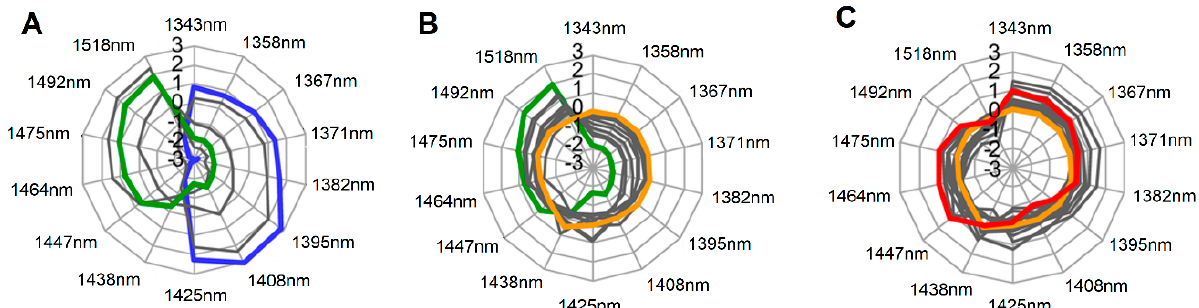
Figure 7. Time dependency of water spectral changes along the fibril formation process depicted by aquagrams. (A) 6 to 10 min for nuclea- tion. (B) 10 to 18 min for elongation. (C) 18 to 30 min for the equilibrium phase. The WASP is plotted every 1 min, starting from the 6th minute, and those at 6 min, 10, 18 min and 30 min are colored by blue, green, orange, and red, respectively, the rest are colored grey. Figure adapted from original.